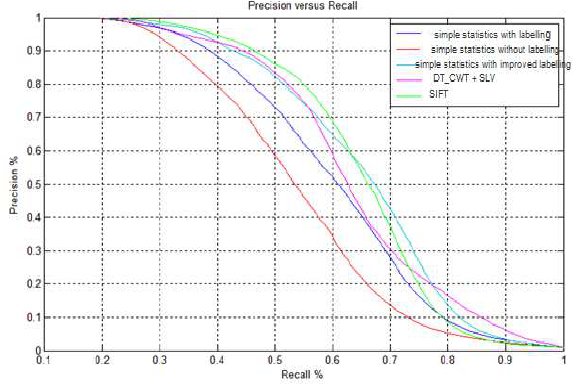
Figure 18. Precision-Recall curves obtained using the 800